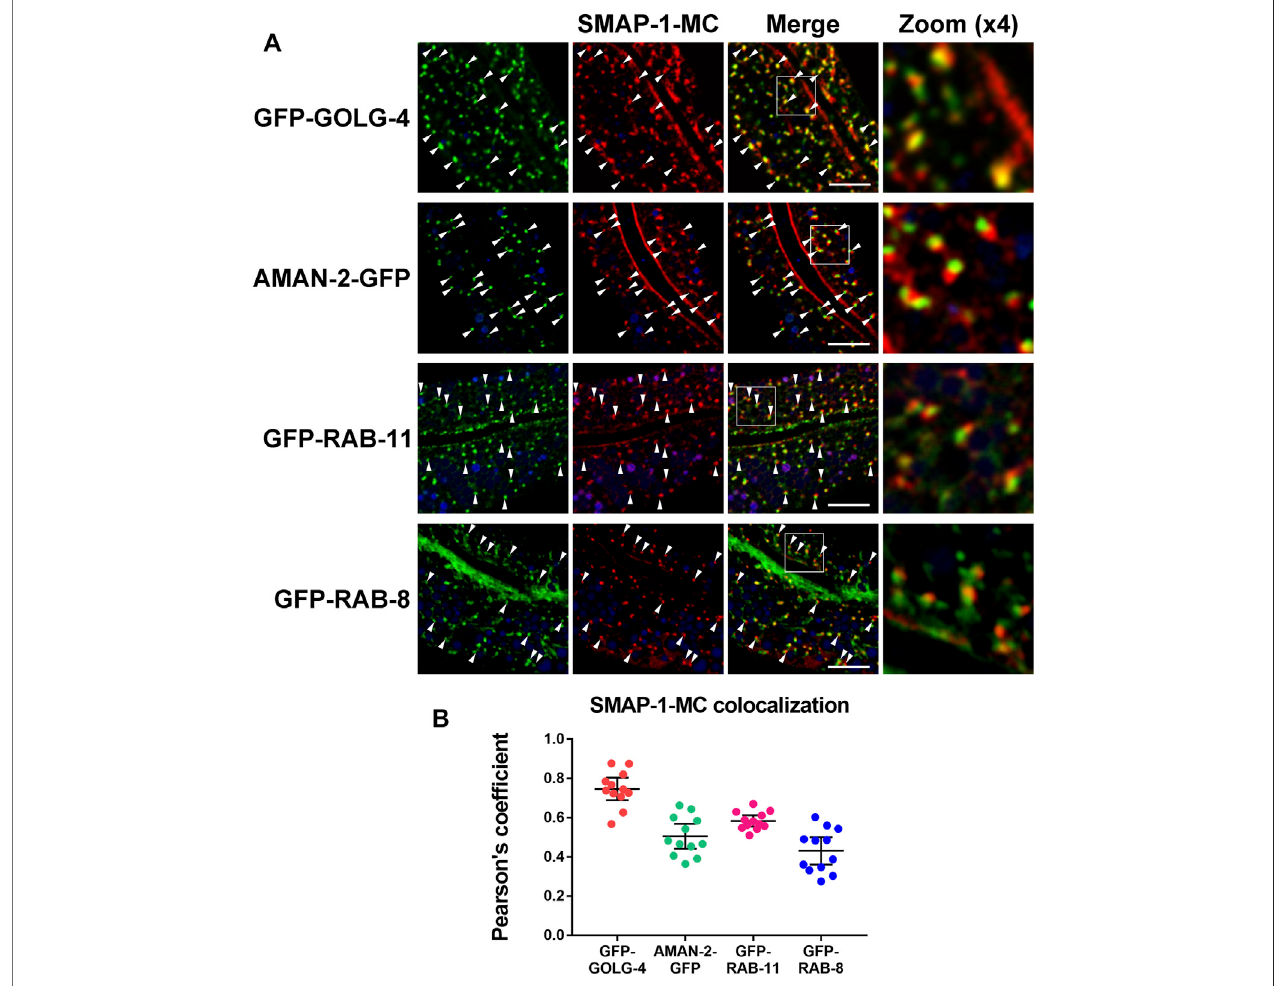
FIGURE 2 | SMAP-1 is localized at the trans-Golgi network. (A) SMAP-1 overlapped well with TGN marker GOLG-4/golgin-245. SMAP-1 and cis- and medial- Golgi marker AMAN-2 were often juxtaposed. SMAP-1 was also juxtaposed to endosome marker RAB-11 and RAB-8. Arrowheads designatestructures co-labeled by GFP and mCherry. (B) Pearson ’ s correlation coef fi cients are calculated, error bars are 95% CIs (n (cid:1) 12 animals). Scale bars, 10 μ m.